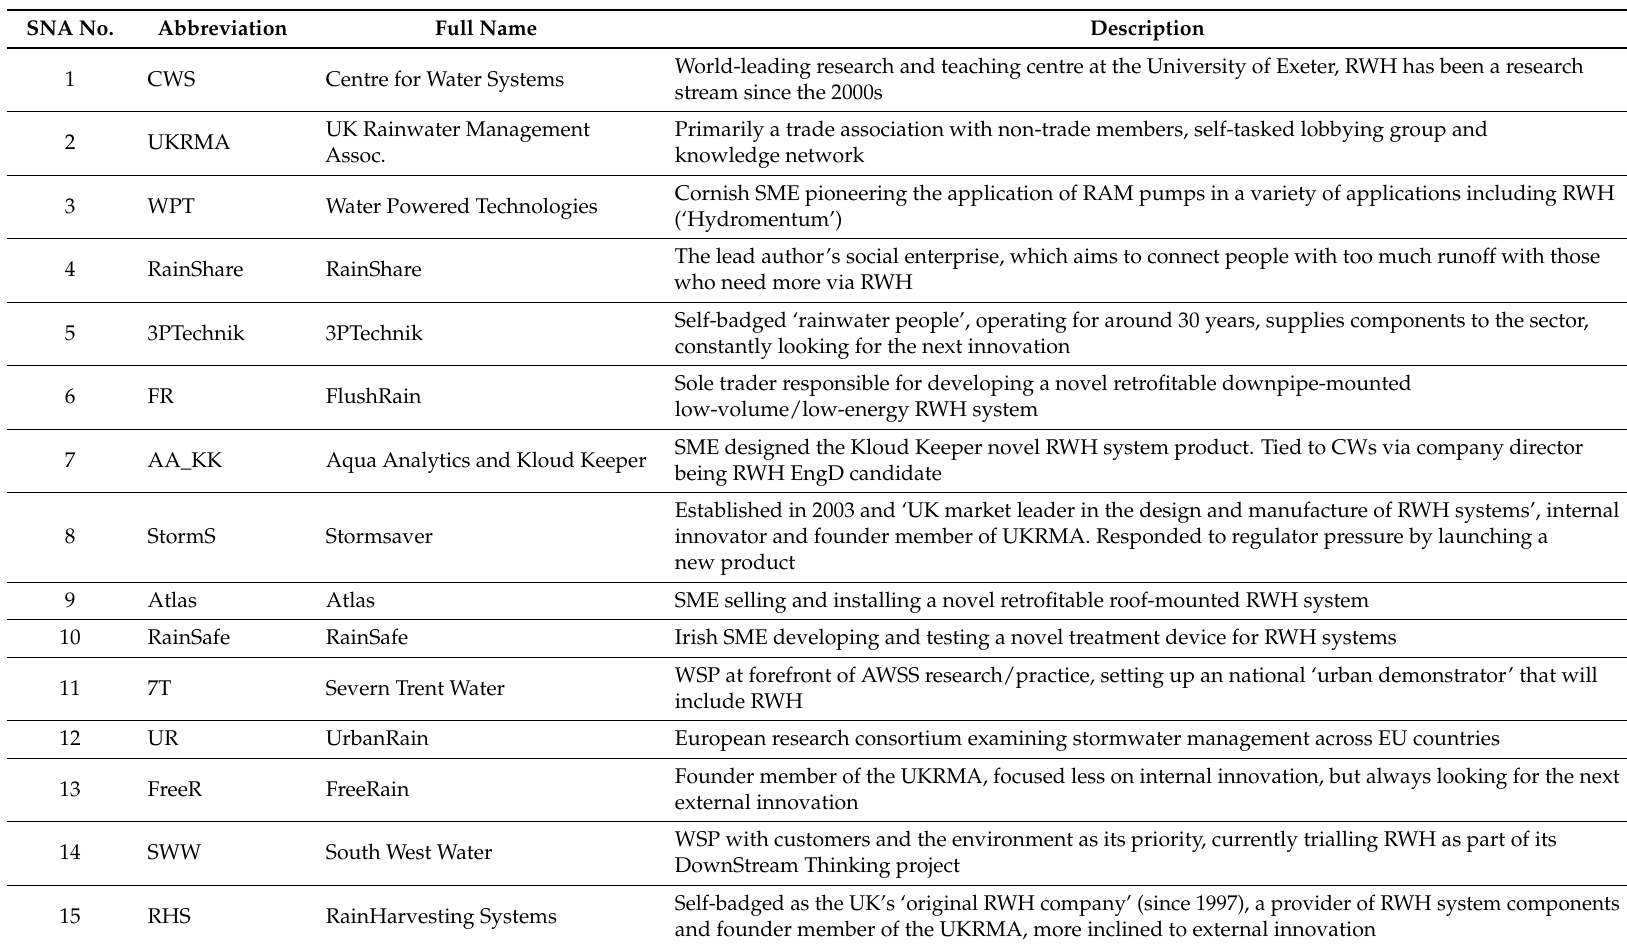
Table 1. Abbreviations, full names and brief descriptions of RWH infrastructure innovators and organisations identified through the modified participatory SNA that are included in the social network analysis. SNA